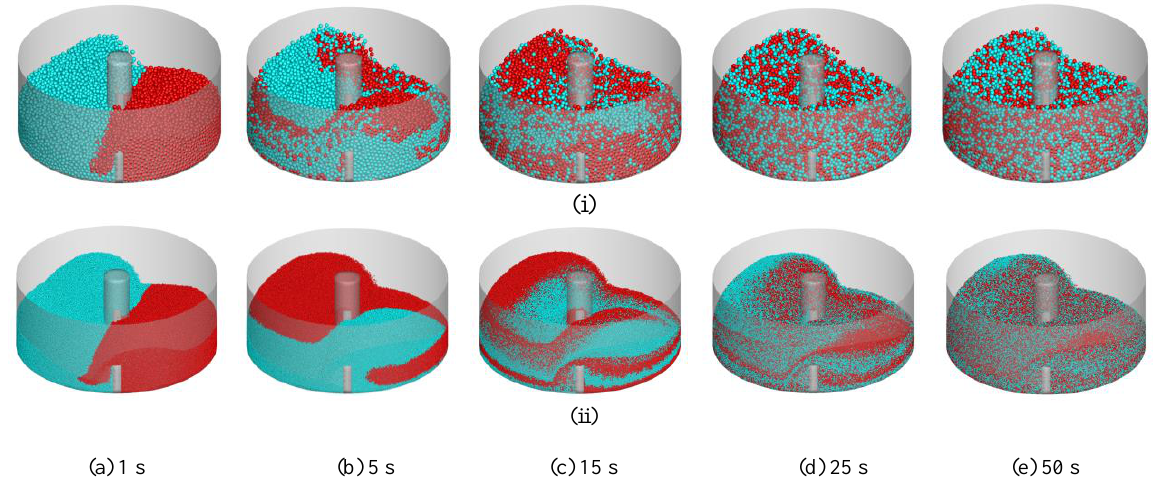
Fig.1 : The comparison for the evolution of the particle flow pattern at 10 RPM for (i) Mixer A, and (ii) Mixer D at (a) 1 s, (b)